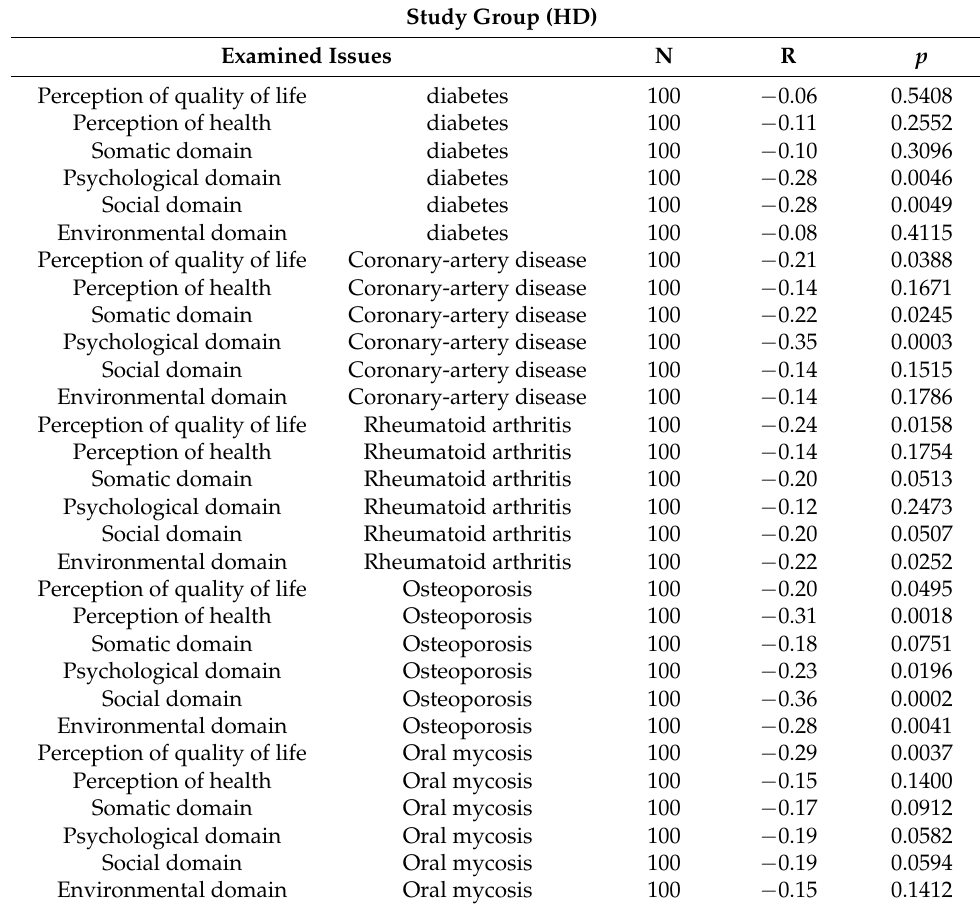
Table 8. Quality of life and associated diseases in the study group